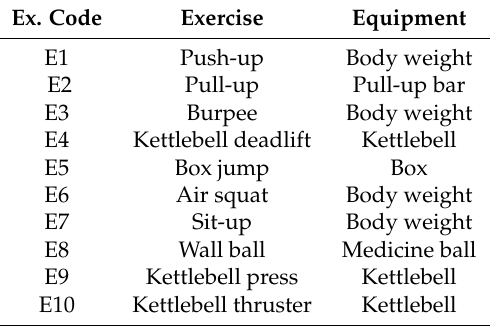
Table 1. List of all exercises with respective code and equipment